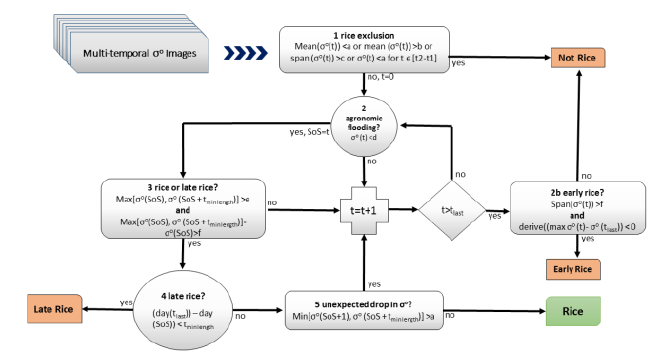
Fig.2 Rule-based rice detection algorithm for multi-temporal C-band σ ° in